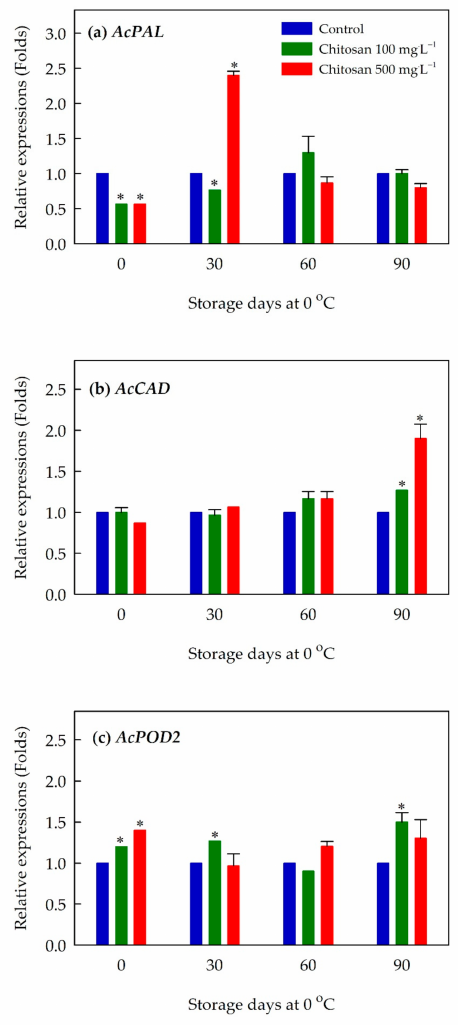
Figure 6. Effects of preharvest chitosan application on relative expression of lignin metabolism- related genes ( a ) AcPAL , ( b ) AcCAD , and ( c ) AcPOD2 during cold storage in ‘Garmrok’ kiwifruit. Vertical bars indicate SE with n = 3. Actin gene was used as internal control and the quantitative RT-PCR data were analyzed using the 2 − ∆∆ CT method. * Statistical difference caused by chitosan- treatment was compared to untreated fruit (control) of each sampling date ( p ≤